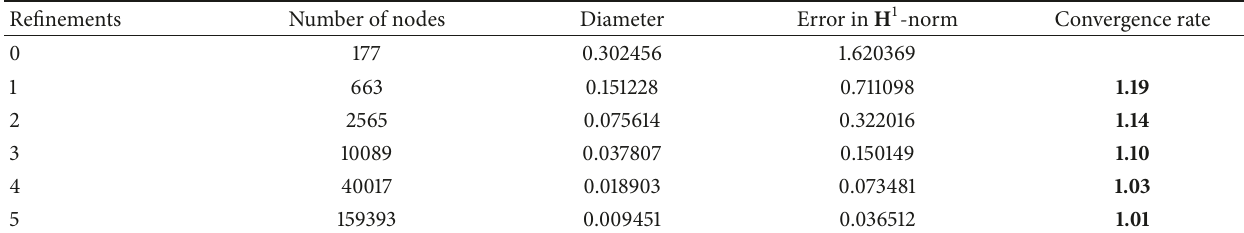
Table 1: Order of convergence in H 1 -norm for homogeneous Dirichlet BC.